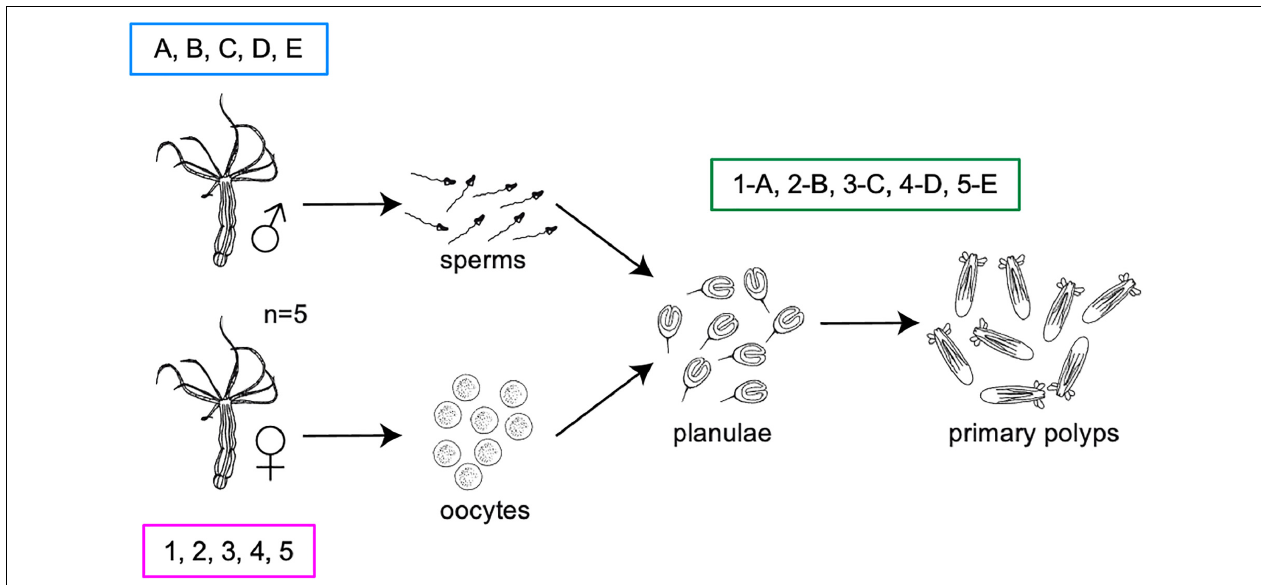
FIGURE 1 | Experimental design. Five pairs of parent polyps were induced for spawning. Their gametes and offspring were collected separately and used for further development and 16S rRNA gene sequencing.